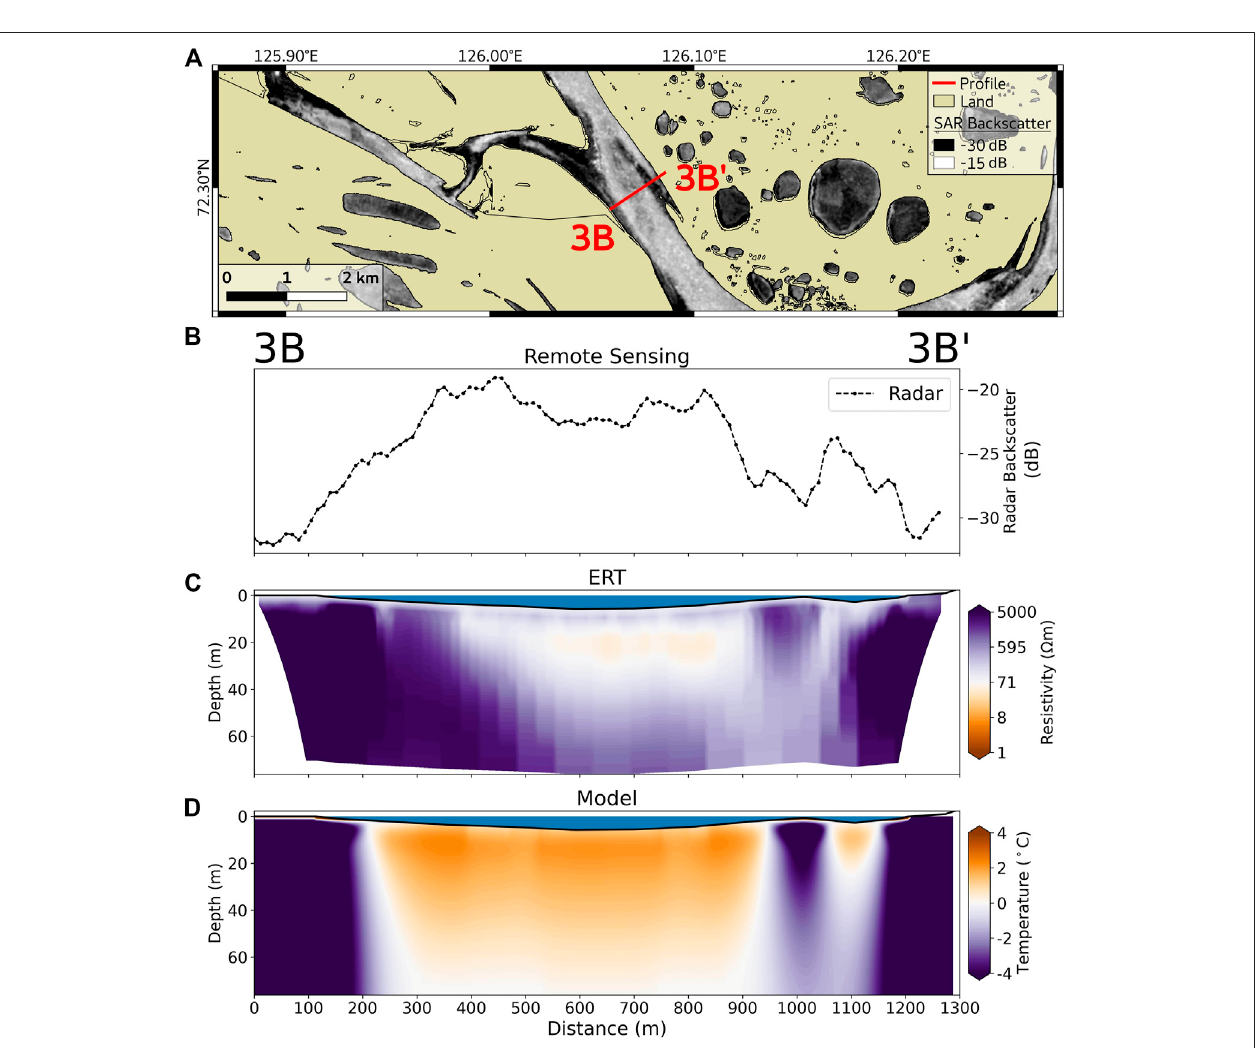
FIGURE6| Pro fi le (3B – 3B ’ ) (forthelocationsee Figure1 ). (A) GPStrackoftheERTpro fi leontopoftheSARSentinel-1medianwinterimageshowingthebedfast (dark)andserpentine(bright)ice. (B) ExtractedSARbackscatteralongthepro fi le. (C) CrosssectionoftheinvertedERTresistivityalongthepro fi le. (D) Modeledsediment temperature along the pro fi